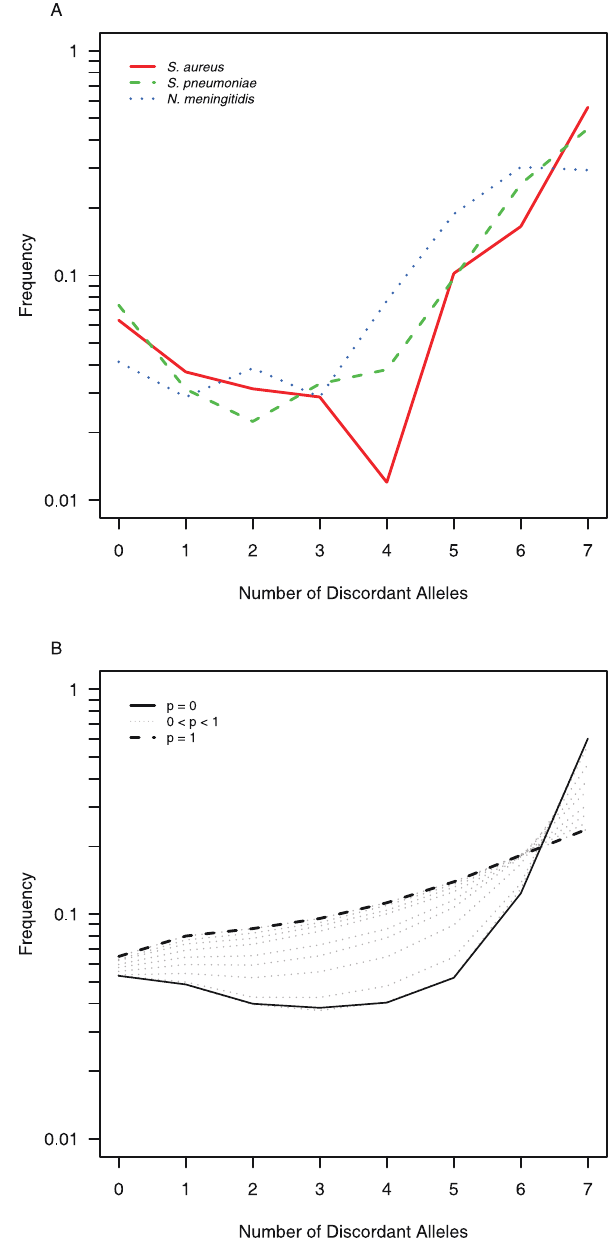
Figure 1. A) Observed distributions of pairwise number of discordant alleles for S. aureus , N.meningitidis , S.pneumonia . Data from [18] [19] [20], cited in [11]. B) Distributions of pairwise number of discordant alleles drawn from simulated networks with various values for the small world parameter p .